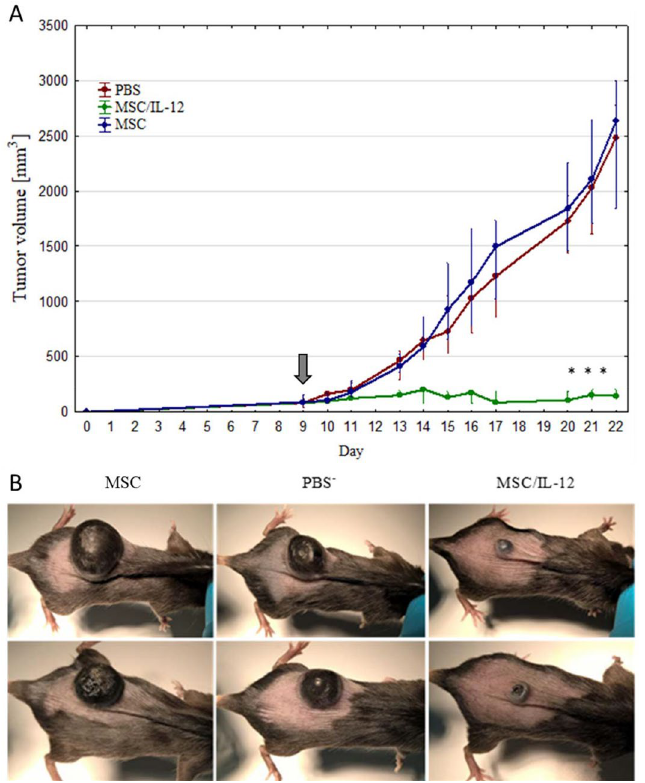
Figure 9. Therapy of mice bearing primary B16-F10 melanoma. MSC/IL-12 inhibited the growth of melanoma tumors. ( A ) 9 days after inoculation with B16-F10 cells MSC, MSC/IL-12 and PBS were administered intratumorally to mice (arrow). On day 20th of the experiment, tumors in mice (n = 5) treated with MSC/IL-12 cells were eightfold smaller comparing to tumors in control ( B ) Representative pictures of animals treated with unmodified MSC, PBS - and MSC/IL-12, * p <